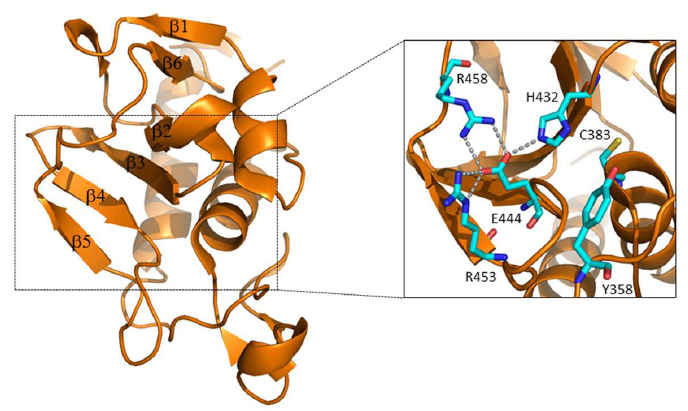
Figure 4. Cartoon representation of the RipA catalytic domain structure. The inset shows a zoom with key residues shown with ball-and-stick.